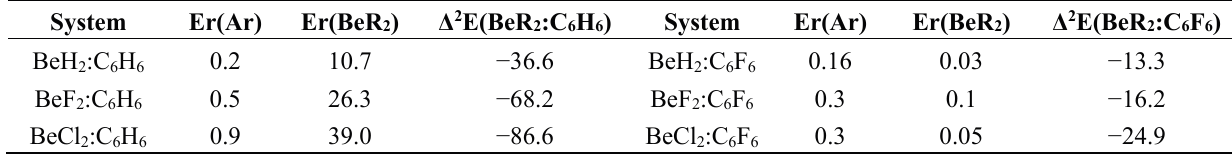
Table 4. Many body Interaction energy (MBIE) partition terms (kJ/mol) in the BeR 2 :C 6 X 6 binary systems.